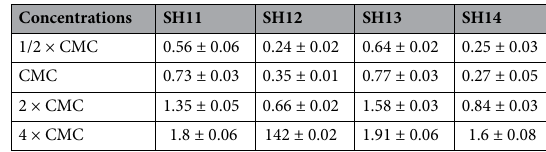
Table 2. The zone of inhibition diameters (cm) of the studied soil bacteria by the surfactant produced by the SH21 isolate.